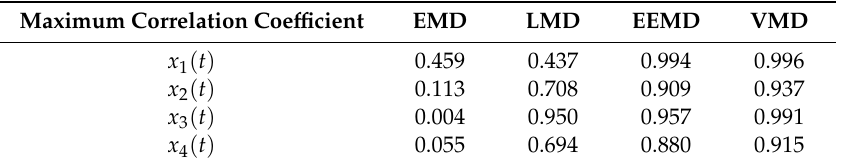
Table 2. Statistical table of maximum correlation coefficient.